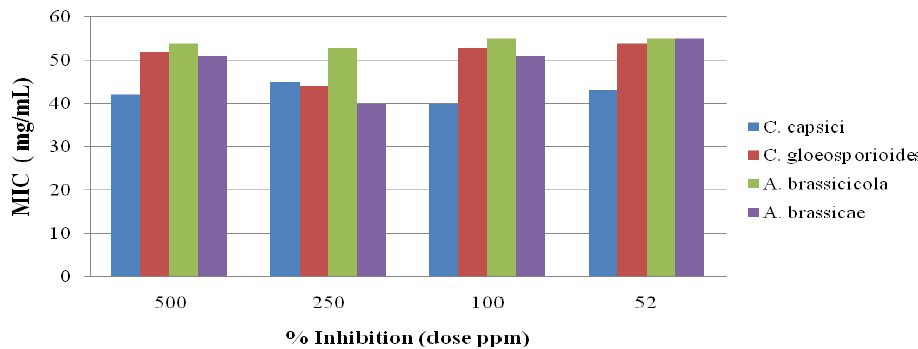
Figure 3. Antifungal results for compound 5b .